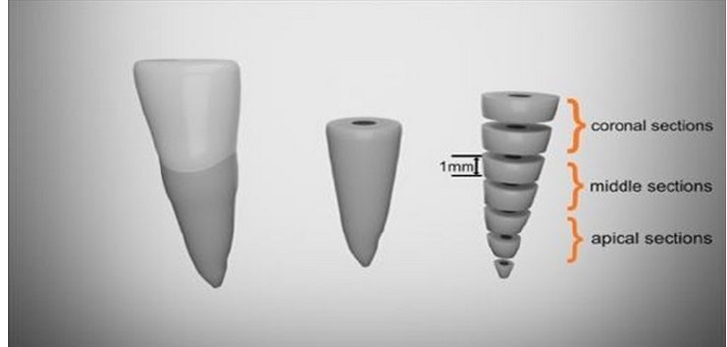
Figure 1. Schematic representation of horizontal cross-sections of the root.